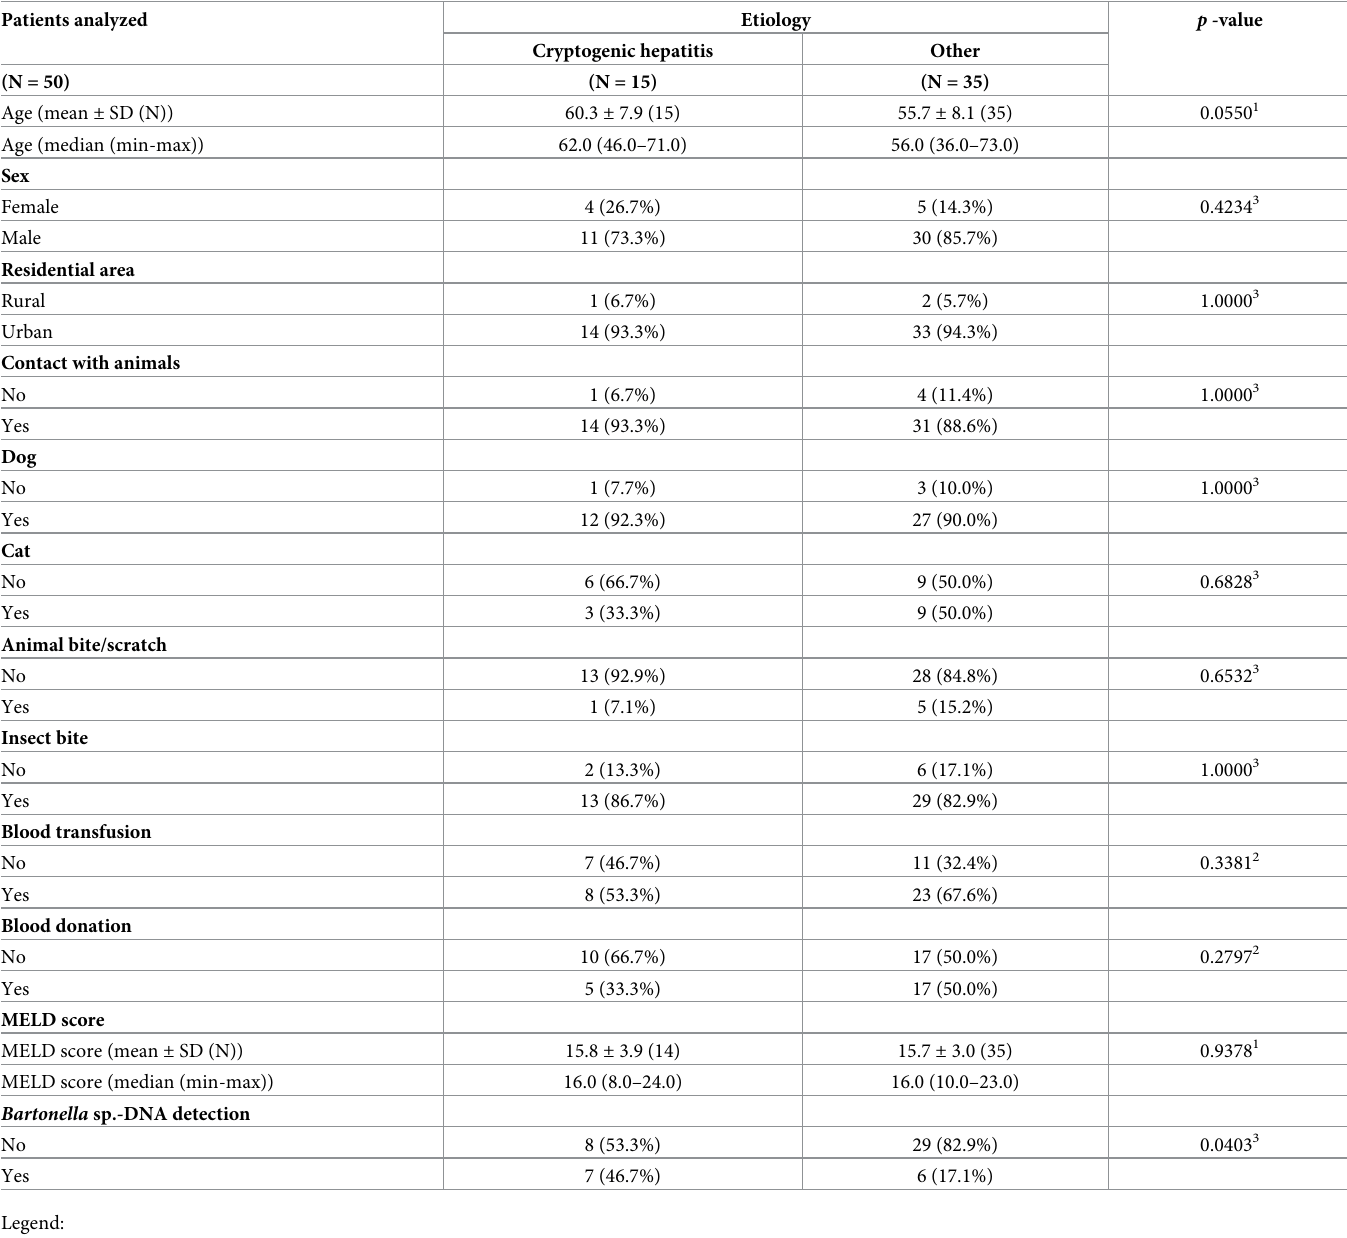
MELD: Model for End-Stage Liver Disease 1 based on Mann-Whitney test 2 based on Chi-square test